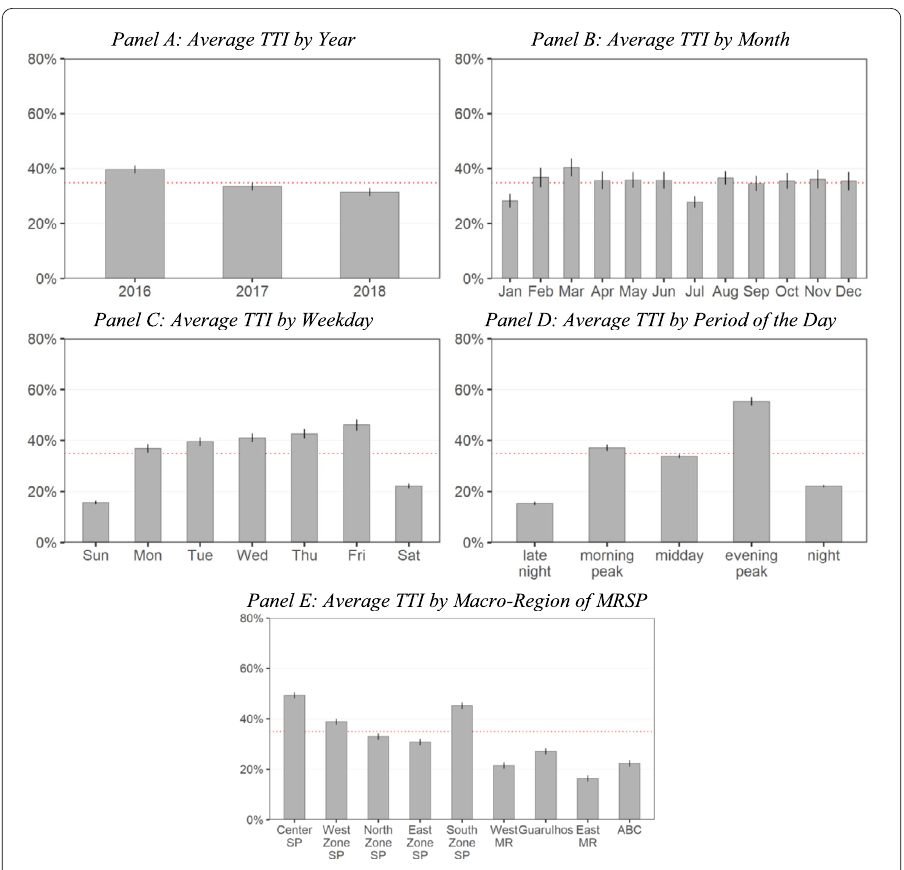
Figure 4 Average congestion index per year. Error bars indicates the 95% confidence interval for the estimated means. The red dotted line indicates the average TTI (34.88%) for the whole period